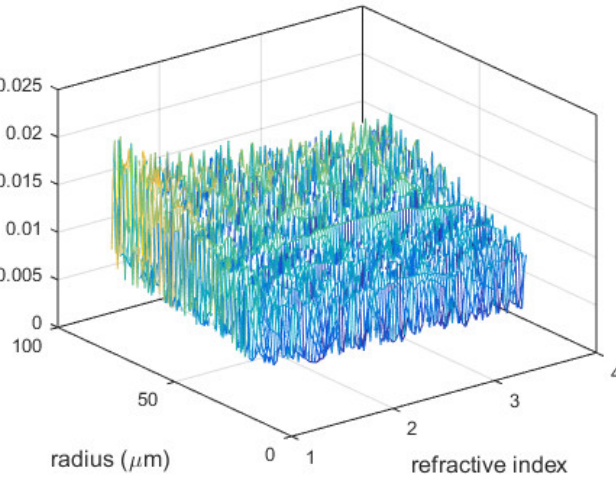
Figure 9. Relative error of the Fresnel method with respect to the rigorous one.